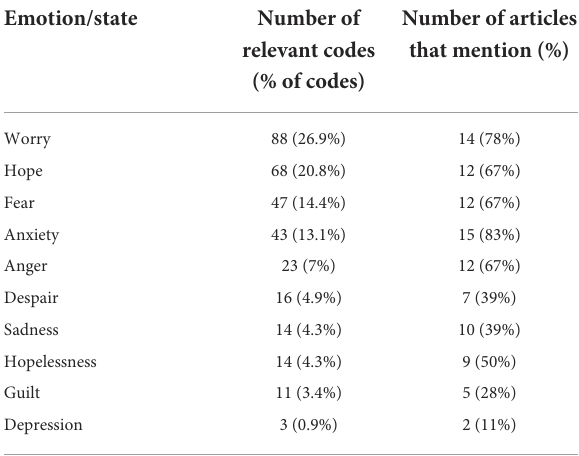
TABLE 3 Coding frequency for each emotion/state in all the selected articles. Emotion/state Number of